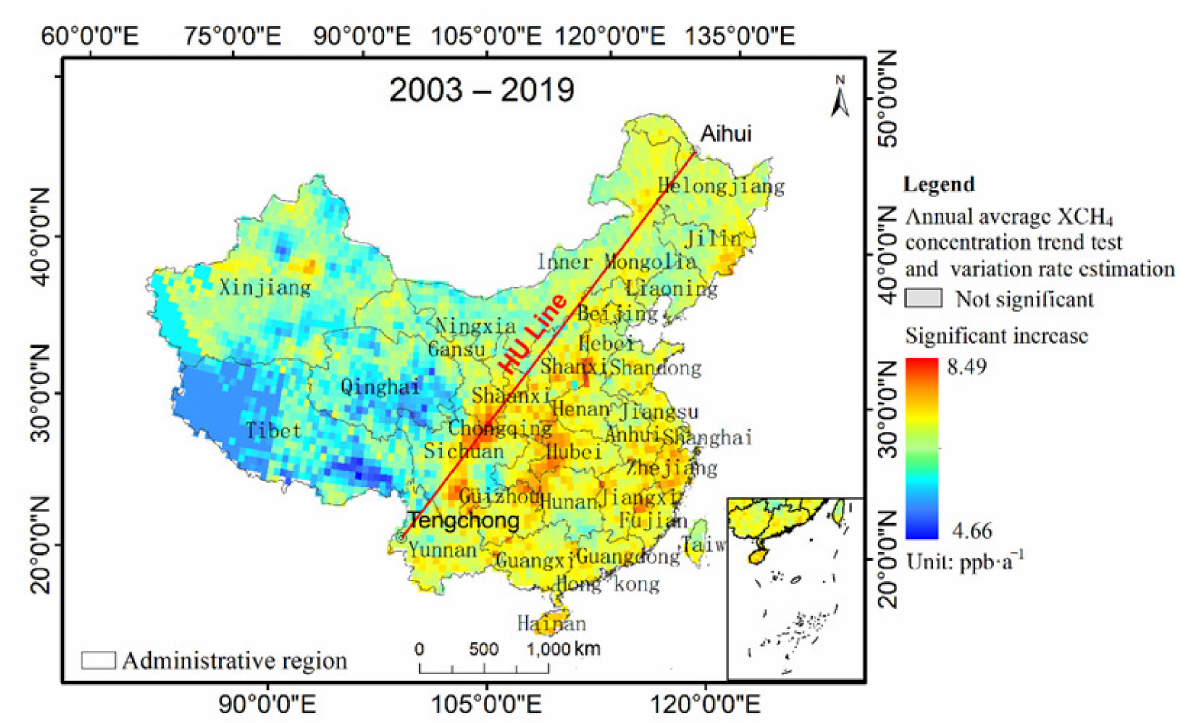
Figure 5. Spatial distribution of the annual increase rate of XCH 4 concentration over China from 2003 to